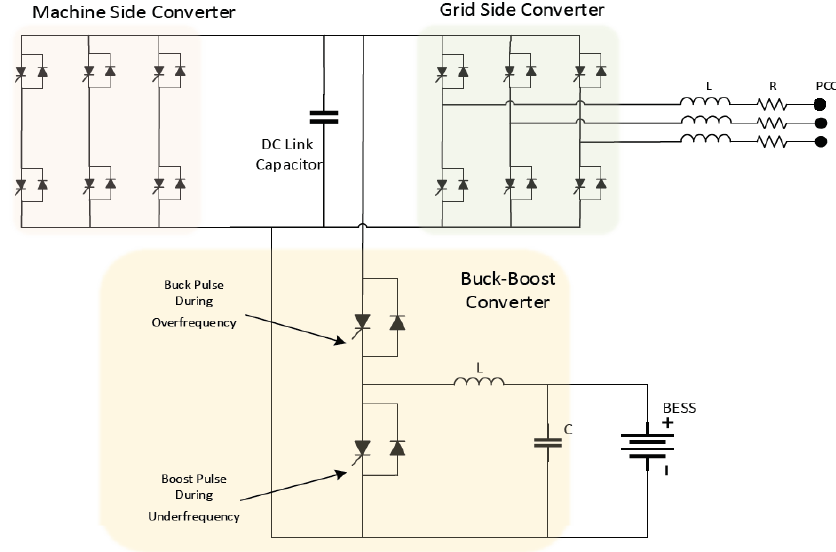
Figure 3. Layout of the Type-4 renewable generators belonging to the renewable energy hub [15].